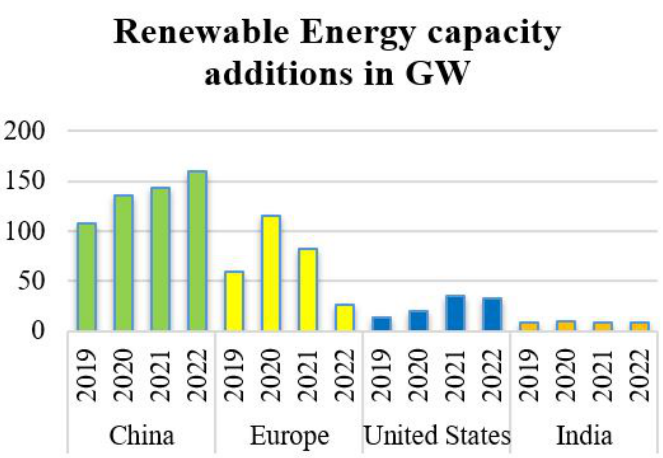
Figure 2. Renewable energy capacity additions in